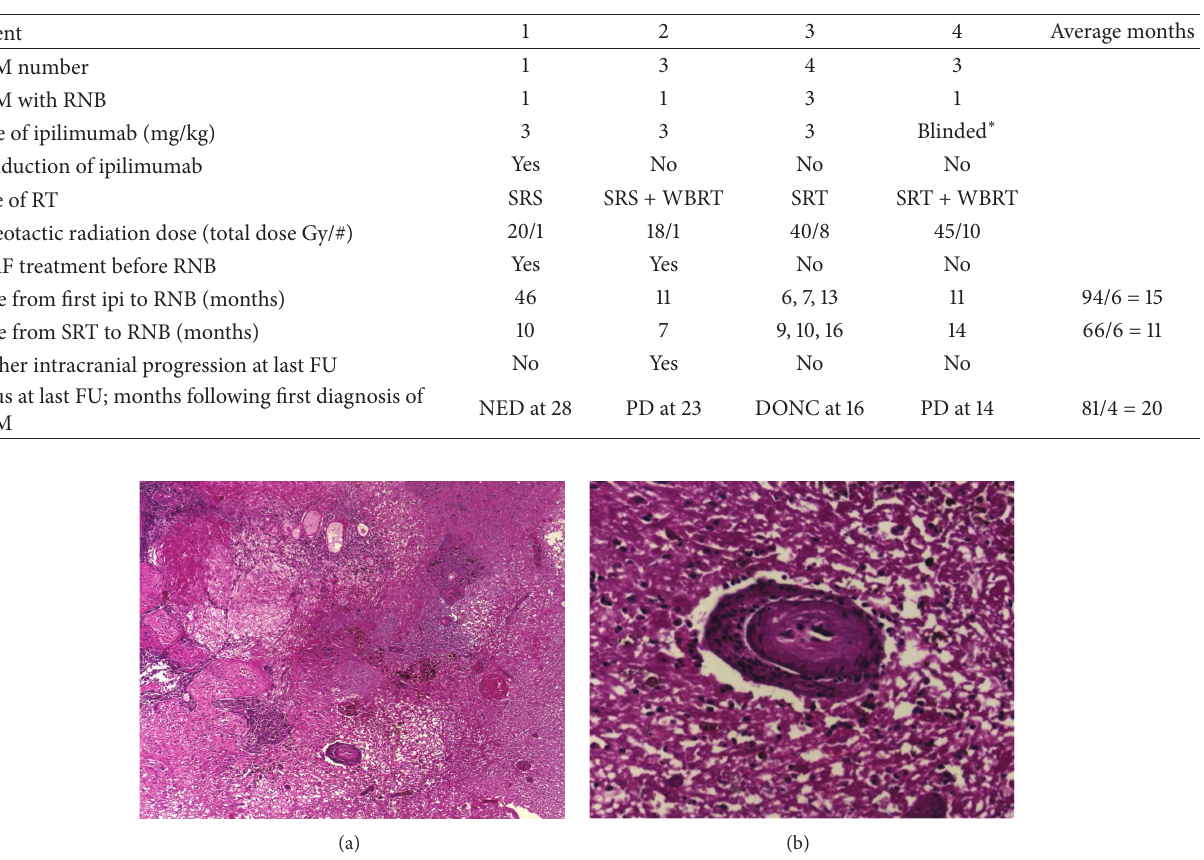
Figure4:Histopathologicalexaminationindicating(a)anareaofinfarction(H&Estaining, × 10)and(b)atransitionalzoneshowingischemia (H&E staining, ×